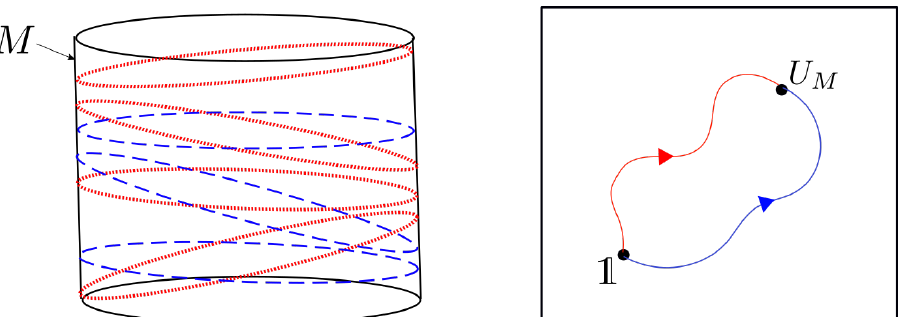
Figure 5: Left: M is taken to be a Lorentzian cylinder, and the blue and red ellipses represent constant time slices of two different time foliations of the cylinder. Right: U is the unitary operator whose matrix elements are calculated by the path integral M on M . Different time foliations define different paths to U